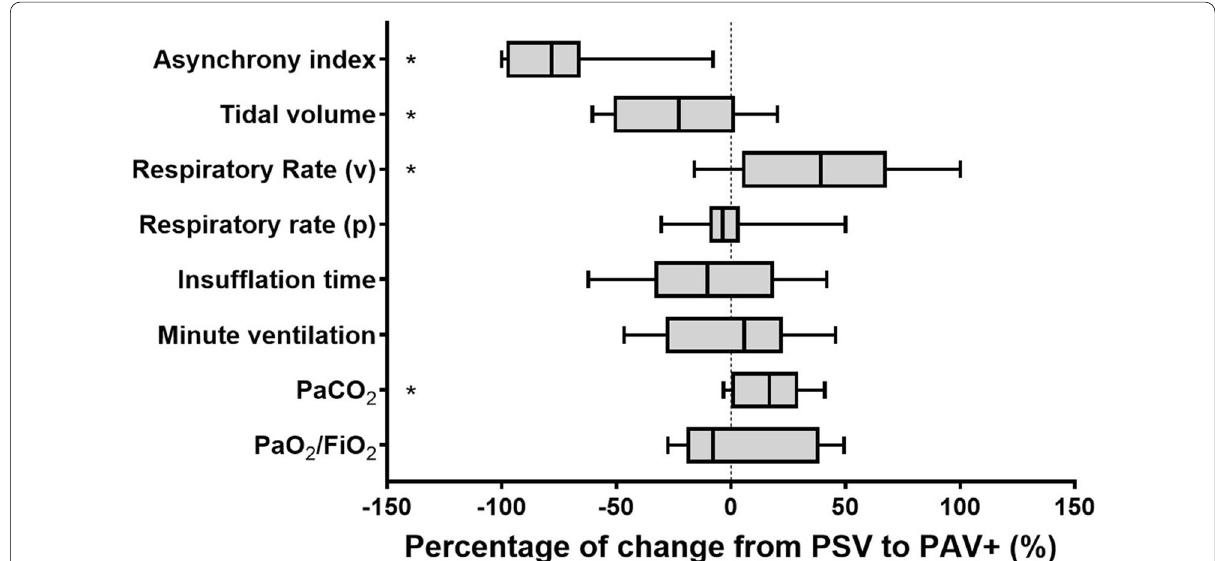
Fig. 3 Ventilatory variables under PSV and PAV . Physiological study. Relative changes, expressed as percentages, of ventilatory variables between + pressure support ventilation (PSV) with the lowest tolerated pressure support level and proportional assist ventilation with load‑adjustable gain factors (PAV ) with the gain adjusted to target a peak muscle pressure between 5 and 10 cmH 2 O. * Denotes statistical +